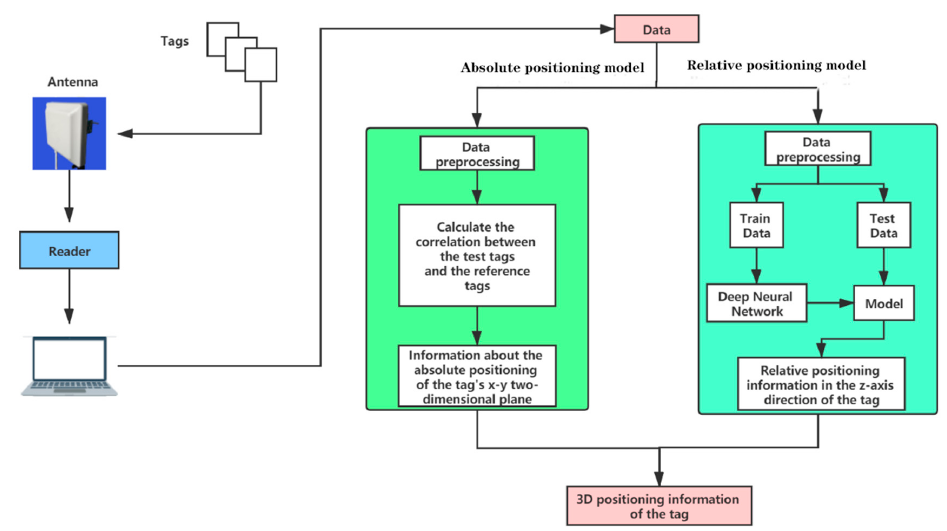
Figure 1. Overall system architecture.